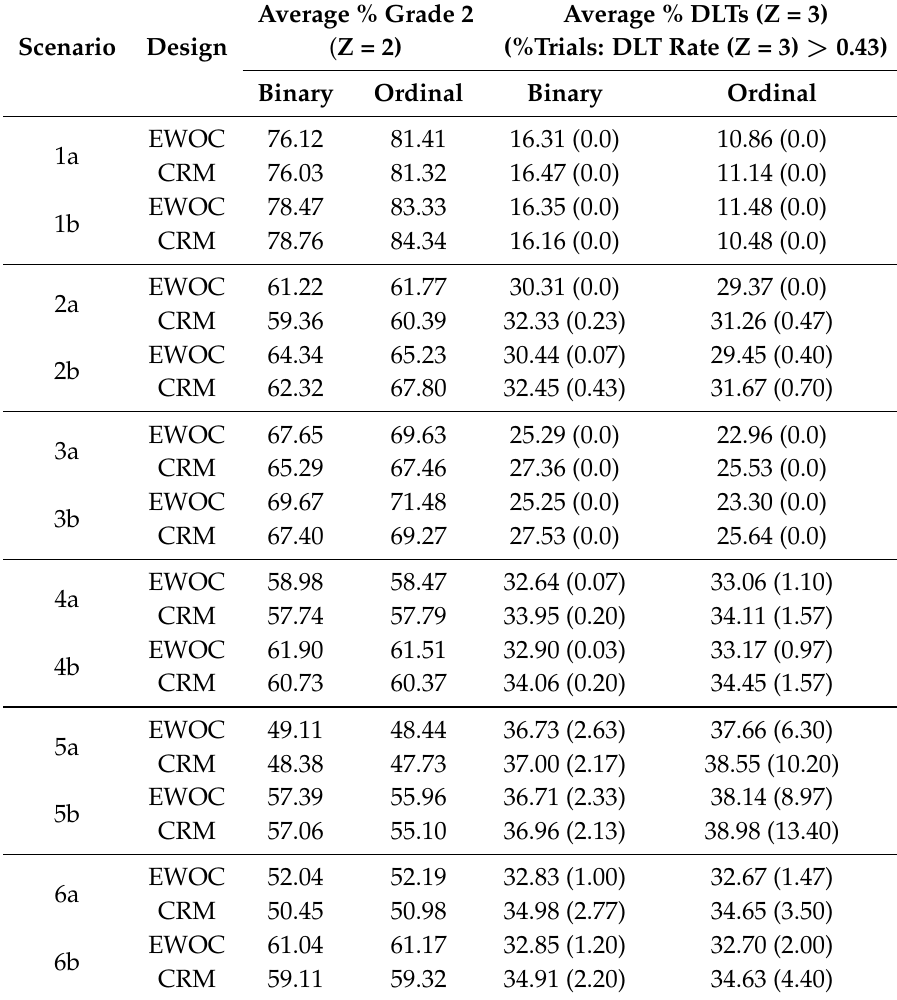
Table 1. Average DLT rate and % trials: DLT rate > θ + 0.10 under Scenarios (1)–(6).